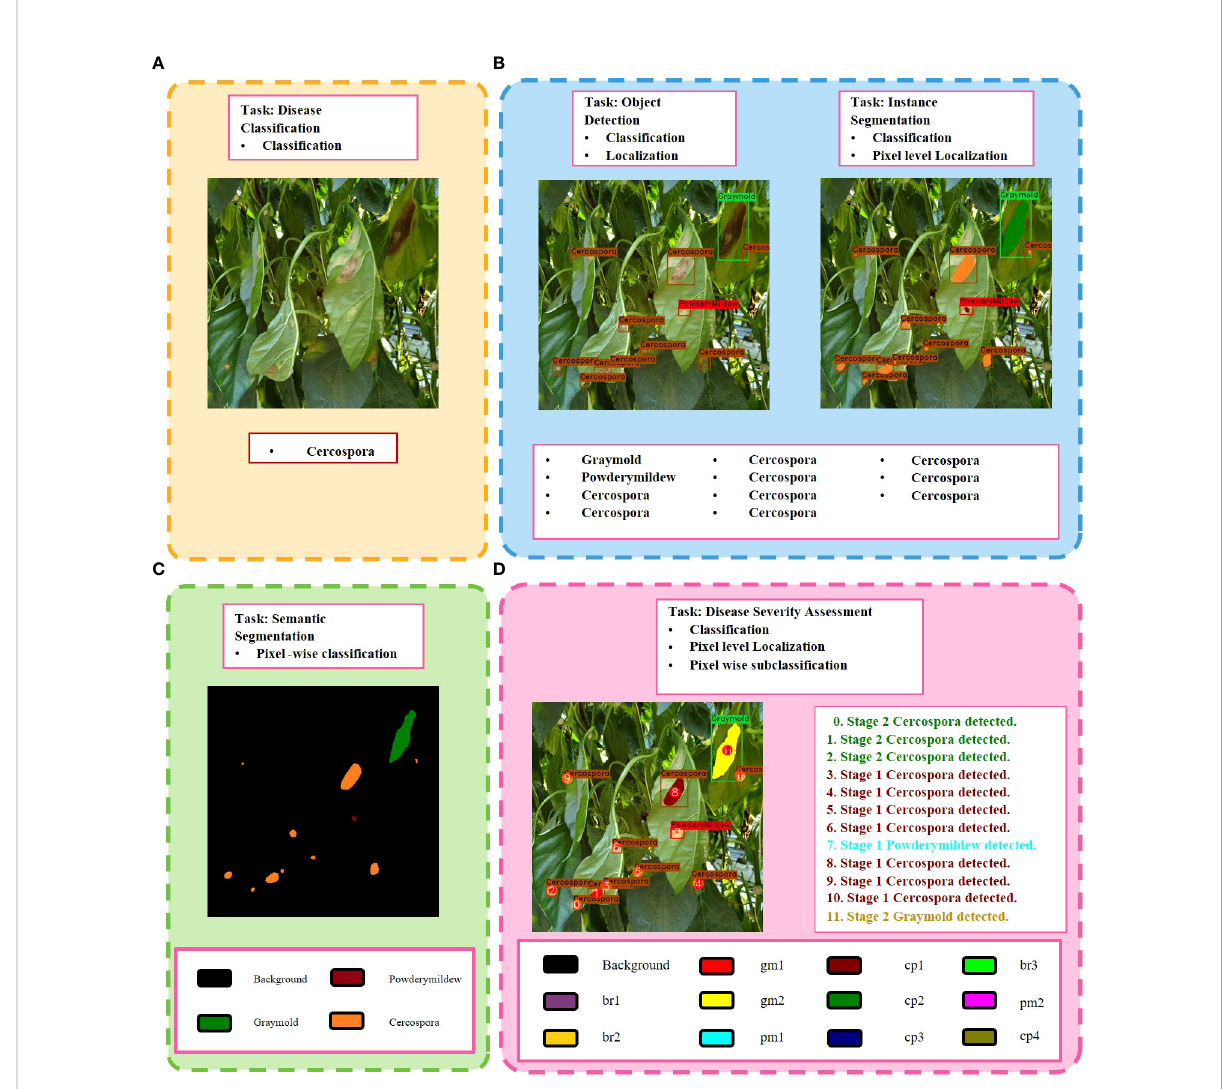
FIGURE 1 Key differences between different frameworks of plant disease phenotyping. (A) Image-based disease classi fi cation. (B) Pixel-level classi fi cation of plant abnormalities. (C) Region-based classi fi cation and localization of plant anomalies. (D) Our proposed Disease Severity Analysis task, which provides more detailed information regarding all anomalies detected in the plant. The color pallet in (C, D) shows the colors given to a severity level of a speci fi c disease throughout this paper. Best viewed in